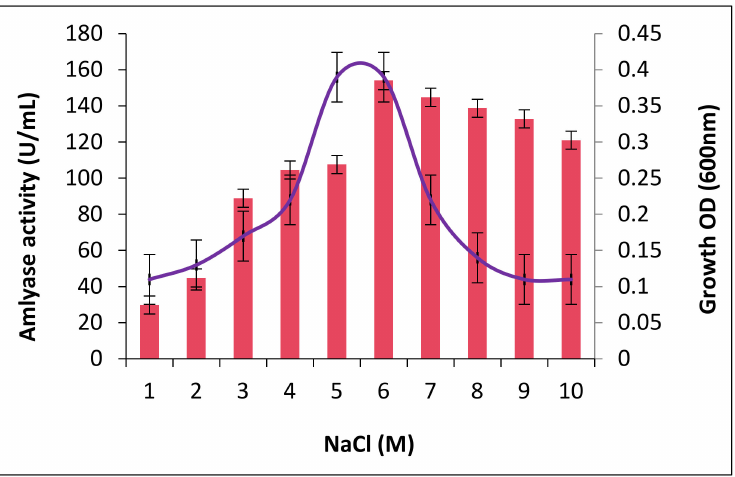
Figure 2. Influence of salt concentration on growth and amylase production in Bacillus sp. H7.